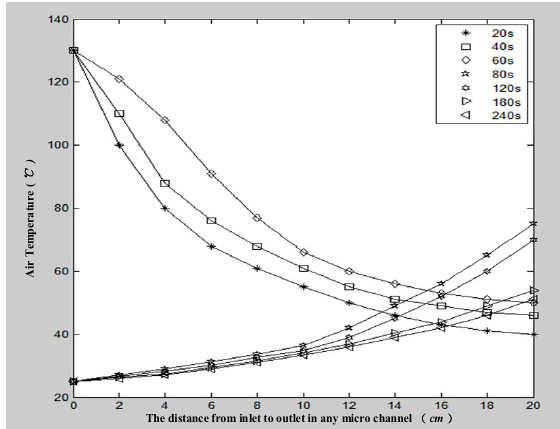
Figure 5. Variation in air temperature at various points along the channel direction.